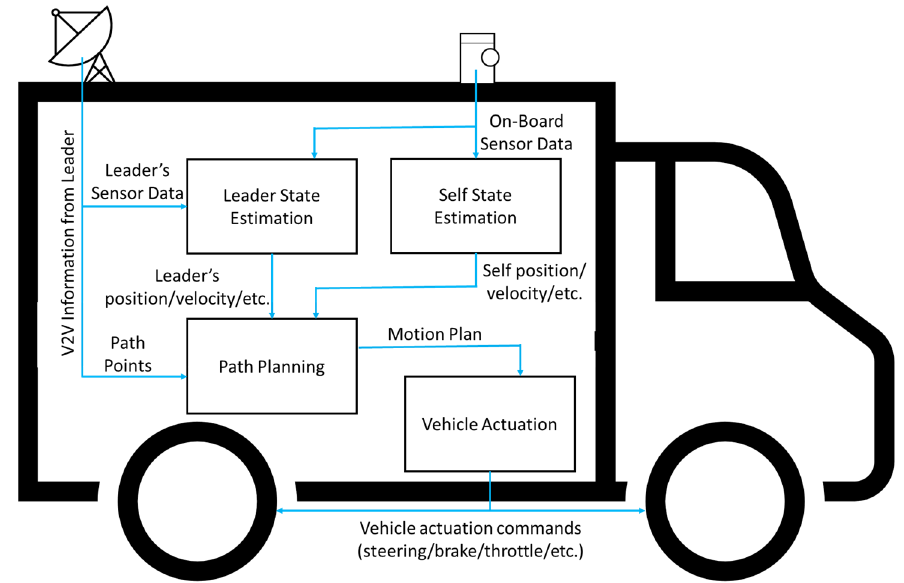
Figure 1. High-level architecture for a follower vehicle in an autonomous ground vehicle convoy.